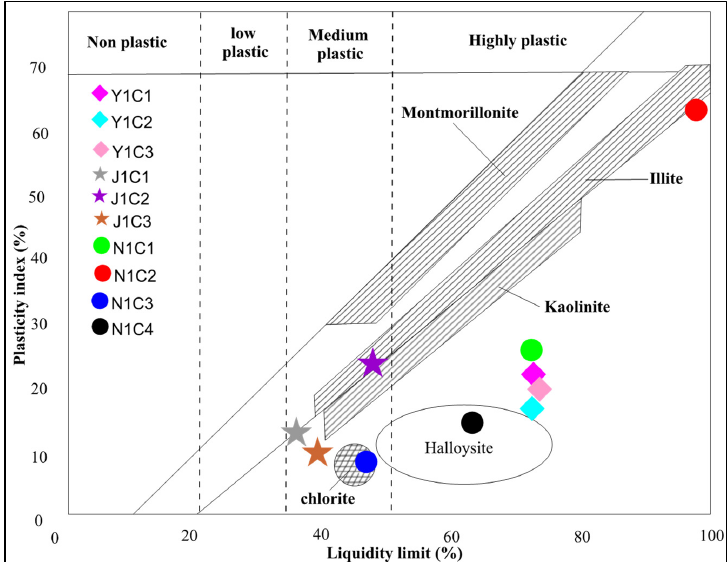
Figure 13. Binary diagram of Holtz and Kovacs [40]: correlation between plasticity and mineralogy of clayey materials of the studied area.